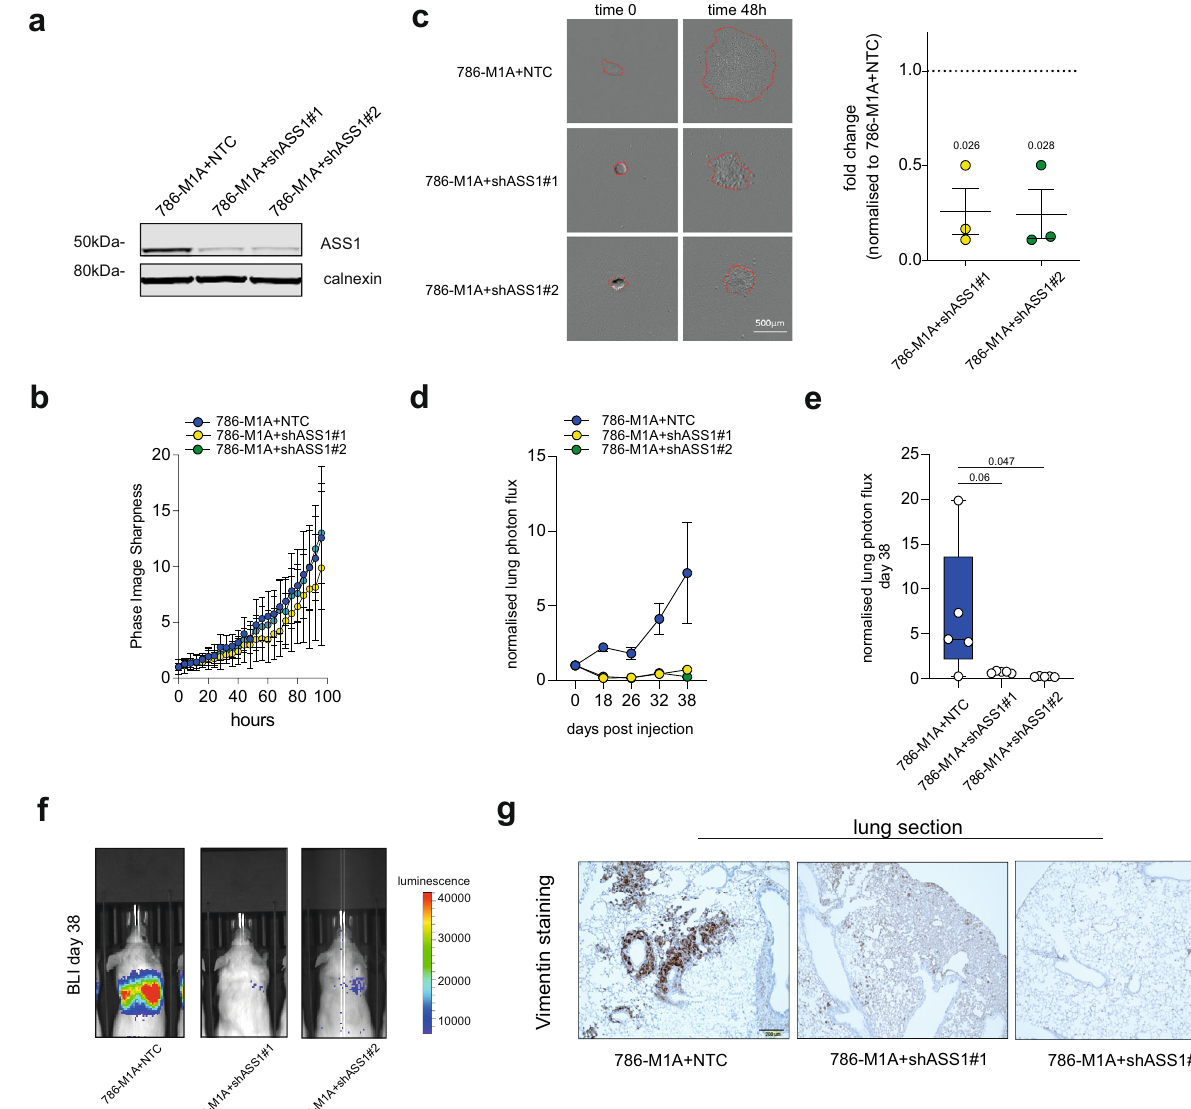
Fig. 7 | ASS1 supportsmetastatic invasioninvitroand invivo.a Westernblot of the ASS1 levels in cells stably cultured in Plasmax upon ASS1 silencing using two different shRNA constructs. Calnexin was used as an endogenous control. b Measurementof786-M1Acellproliferationaftersilencingof ASS1 usingIncucyte. Con fl uency values are shown as phase image sharpness calculated through Incu- cyte software±S.E.M. N =3 independent experiments. c Representative images of the indicated cell lines at time 0 and after 48h (left) upon growth as spheroids in collagen (area marked in red). Pictures were obtained from Incucyte. Scale bar is 500 μ m. Quanti fi cation of the cell spreading area in the collagen matrix at 48h is represented as mean±S.E.M from N =3 independent experiments. Statistical sig- ni fi cance was calculated using two-tailed one-sample t -test (null hypothesis